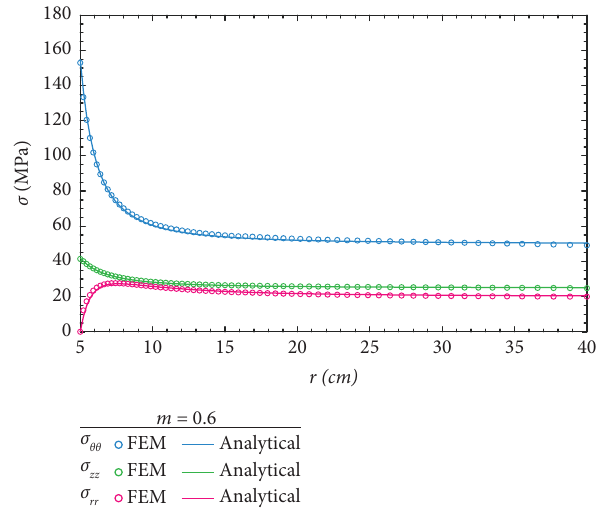
Figure 8: Te stresses along the minimum in situ stress ( θ � 0 0 ) .